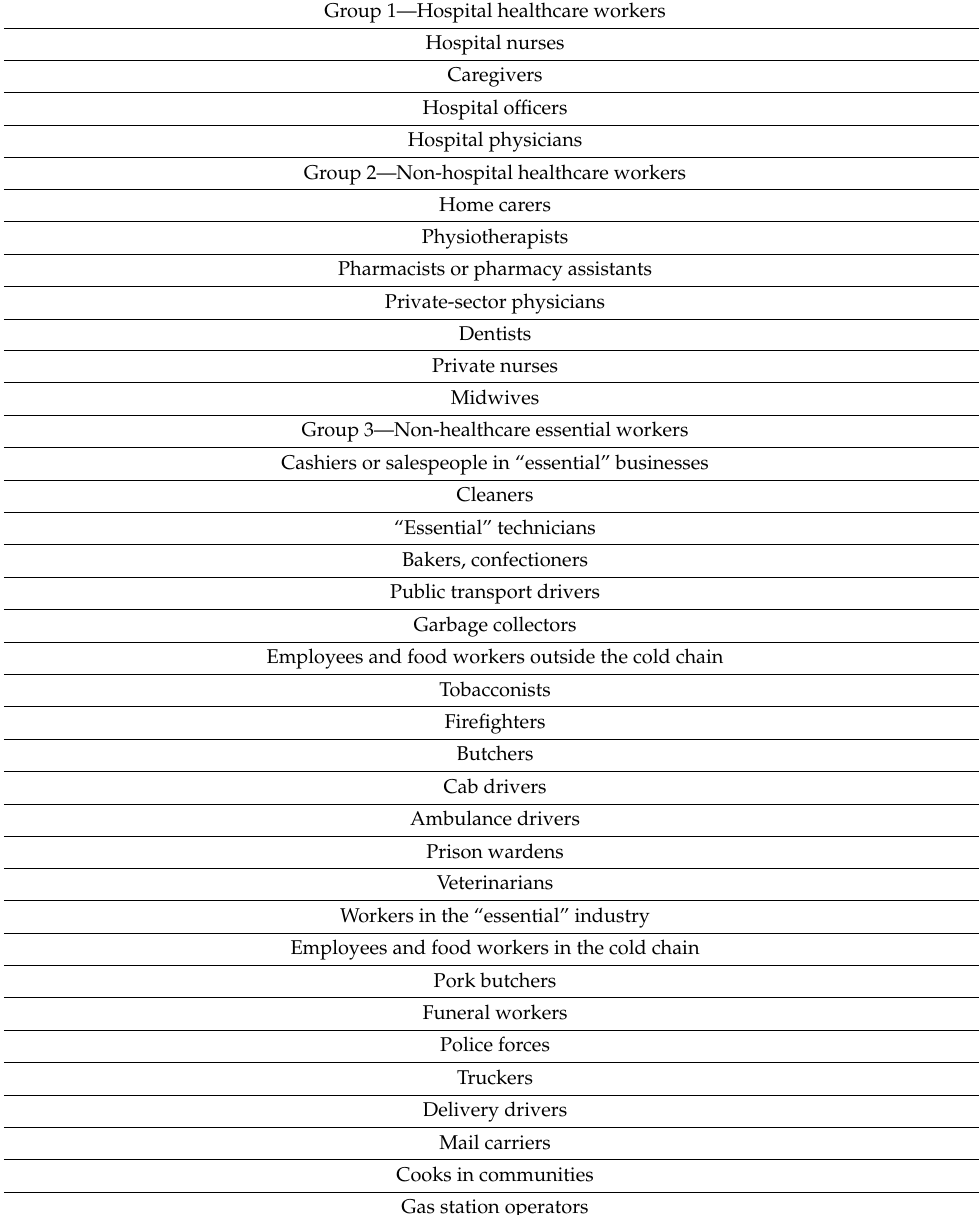
Table A1. List of key workers in France during the first